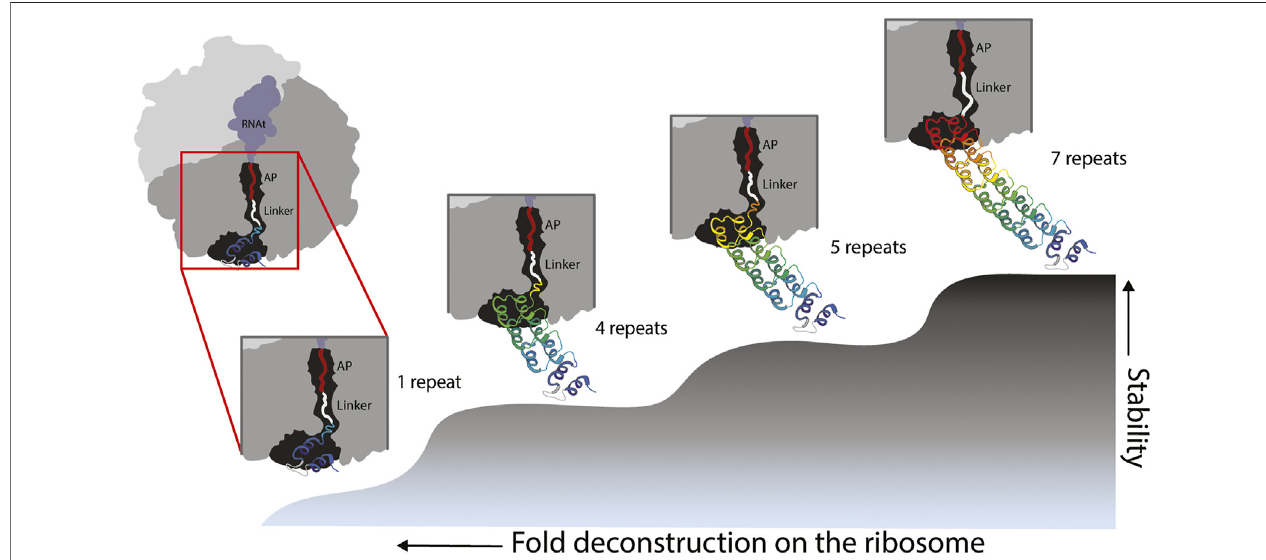
FIGURE 4 | Model offold deconstruction on the ribosome. The Ankyrin Domain ofthe Drosophila Notch Receptor might have arisen by duplication and fusion of a singlerepeat.Fourprobablecompacted/foldedstatesareshown,thelastthreestatescorrespondtopeaksintheforcepro fi le:L-279=7repeats,L-224=5repeatsand L189=4repeats.Accordingtotheforcepro fi leof Figure3 ,thefull-lengthproteinfoldsatL40fromthepeptidyltransferasecenteroftheribosome(L-279).Itisthesame case for truncated versions with 4 and 5 repeats. During the truncation process of the version with 5 repeats for instance, 1/2 sixth repeat (orange) becomes an unstructuredlinkerbecauseitcannotintrinsicallyfoldduetomissingresideswithintherepeat.Itisthesamecaseforthe4repeatsversionoftheprotein.Inthecaseofan ancestralstaterepresentedbyasinglerepeat,theforcepro fi leshowsamodest,andsomehow fl atconstantincreaseinfFL,thismightre fl ectspullingforceexertedbyan unstructuredsinglerepeat.Itisunlikelyasinglerepeatwouldproduceade fi nedpeakdueitsintrinsicinstability.However,inearlystagesofproteinevolution,aproto-exit tunnel might have promoted the formation of super secondary structures such as the repeats of the Ankyrin